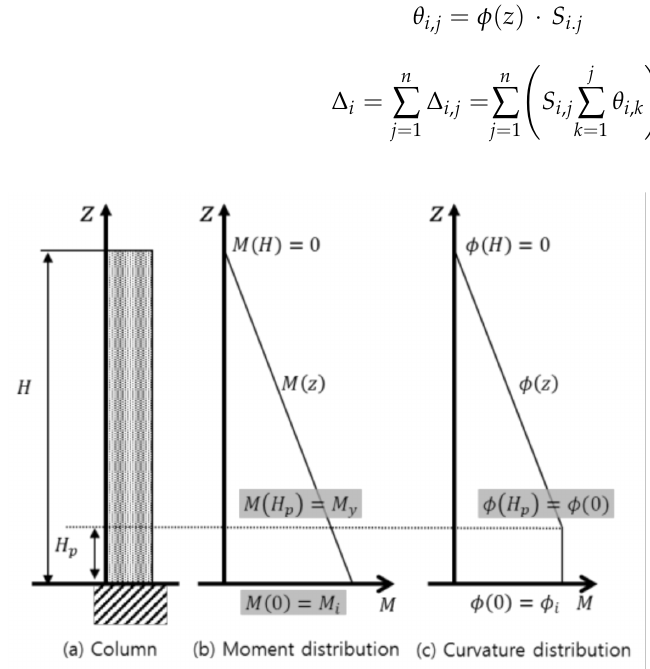
Figure 8. Moment and curvature distribution.